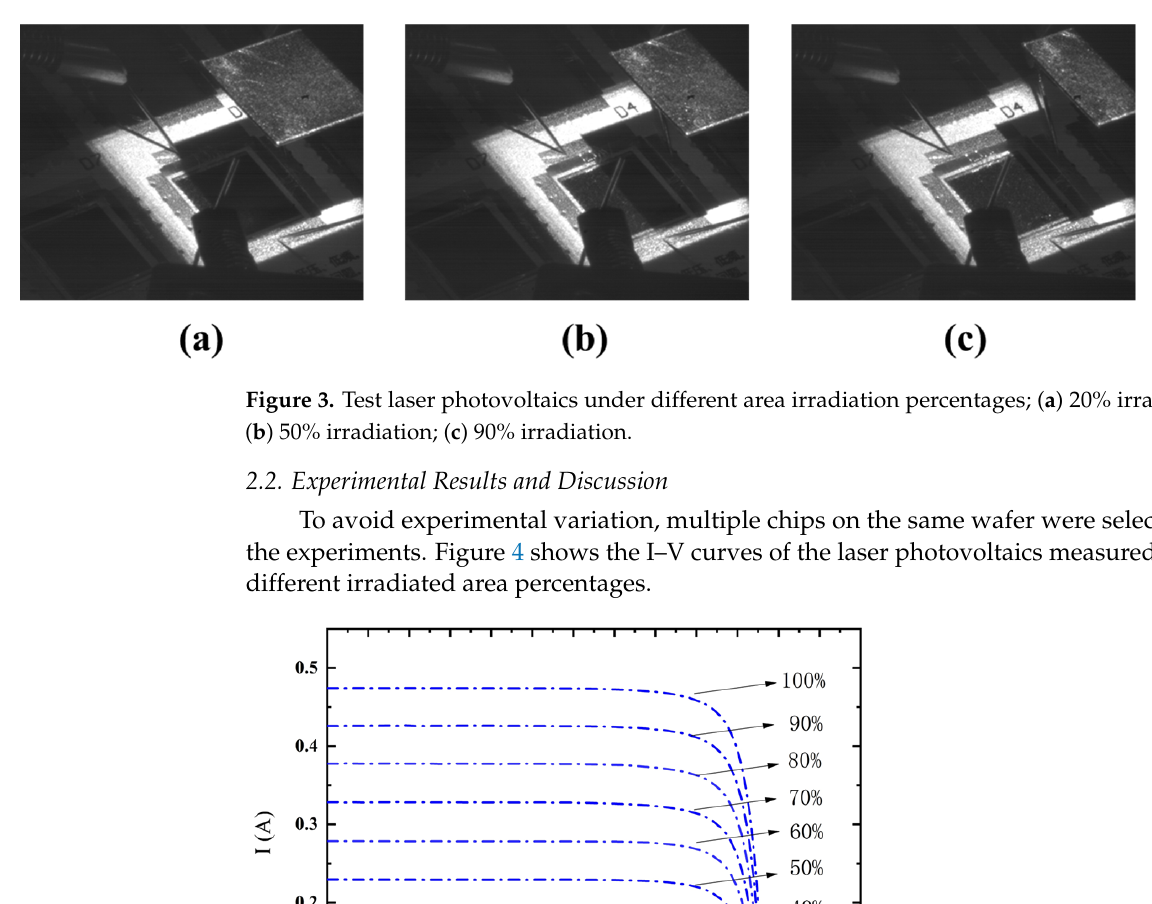
Figure 2. Light spot intensity distribution after homogenization.